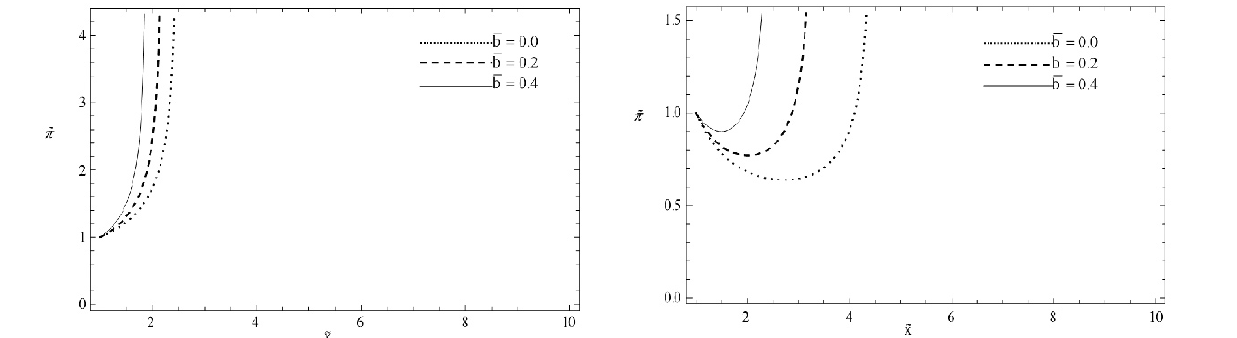
˜ π ) for m = 0 , ω = − 0 . 5 and